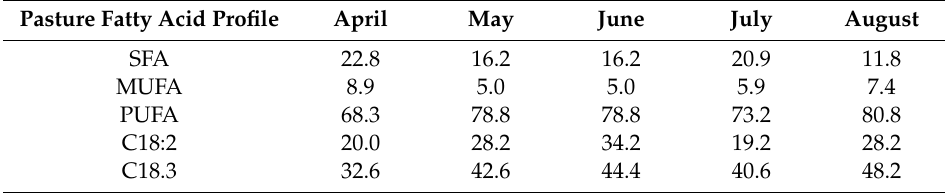
Table 5. Fatty acid profile (% of total fatty acids) of pasture as function of sampling months.